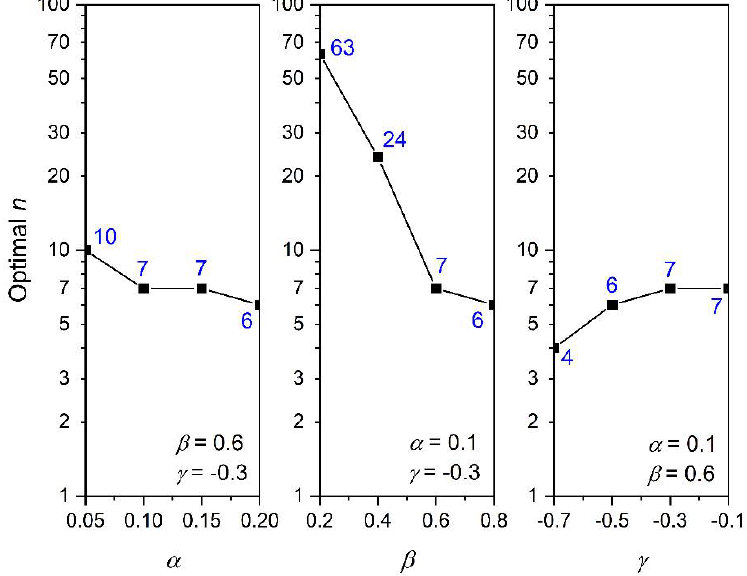
Figure 6. Effects of the model parameters α , β , and γ in the TTS intensity function on the optimal n value ( d = 5%, C c / C m = 1, and C r / C m = 10 The second observation is that the effect of (cid:2010) is much larger than those by (cid:2009) and (cid:2011) . As (cid:2010) drops from 0.8 to 0.2, the optimal (cid:1866) correspondingly increases from 6 to 63, which